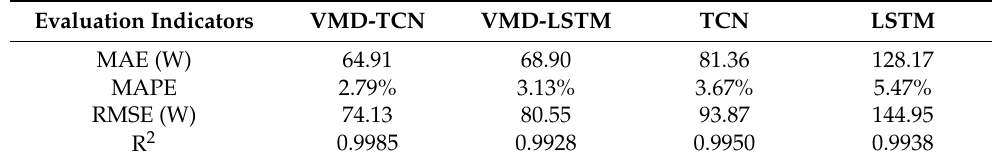
Table 2. Statistical table of the prediction